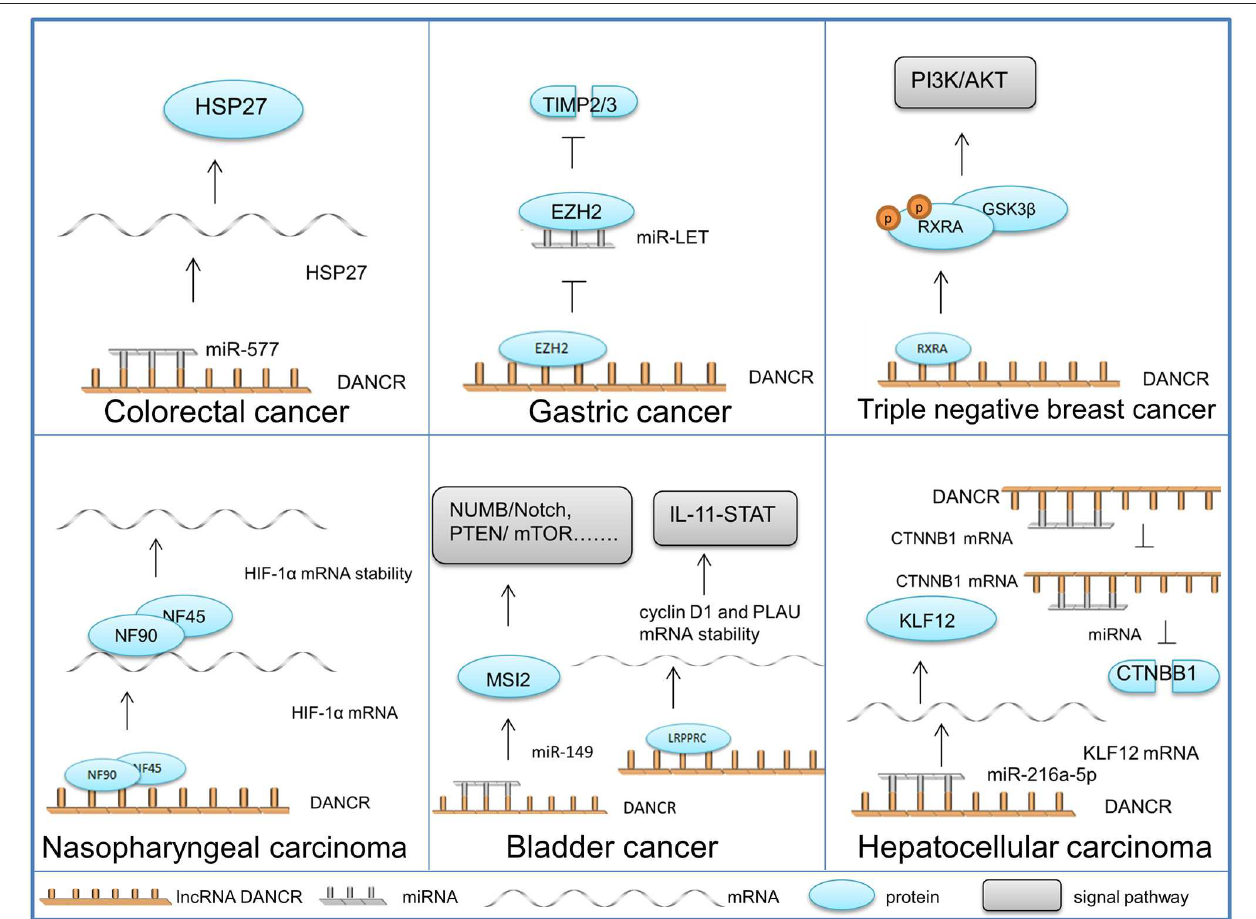
FIGURE 2 | Functional properties and molecular mechanisms of DANCR in different cancers. The schematic illustrates the mechanisms of DANCR in different cancers.